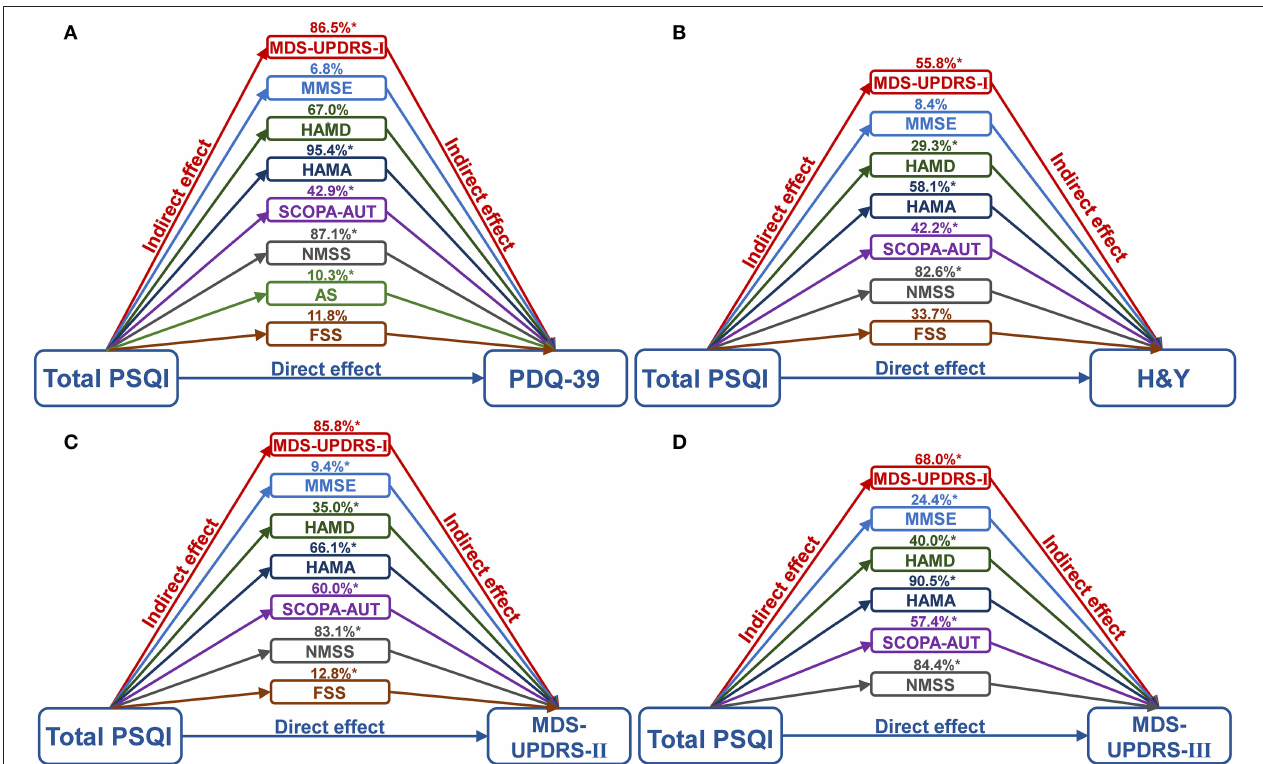
FIGURE 3 | Mediation analyses of NMSs with global sleep quality and PD. It was found that various scales of NMSs, consisting of MDS-UPDRS-I, MMSE, HAMD, HAMA, SCOPA-AUT, NMSS, AS, and FSS, could mediate the effect of quality of life (A) , and the severity of PD, including H&Y stages (B) , MDS-UPDRS II (C) and III (D) with a range of 6.8–95.4%. * The p -value was survived after Bonferroni correction ( p < 0.001). AS , Apathy Scale; FSS , Fatigue Severity Scale; HAMA , Hamilton Anxiety Rating Scale; HAMD , Hamilton Depression Rating Scale; MDS-UPDRS , Movement Disorder Society Unified Parkinson’s Disease Rating Scale; MMSE , Mini-Mental State Examination; n, number; MoCA , Montreal Cognitive Assessment; NMSS , Non-Motor Symptoms Scales; PD , Parkinson’s disease; PDQ-39 , 39-item Parkinson’s Disease Questionnaire; PSQI , Pittsburgh Sleep Quality Index; SCOPA-AUT , Scale for Outcomes in PD for Autonomic